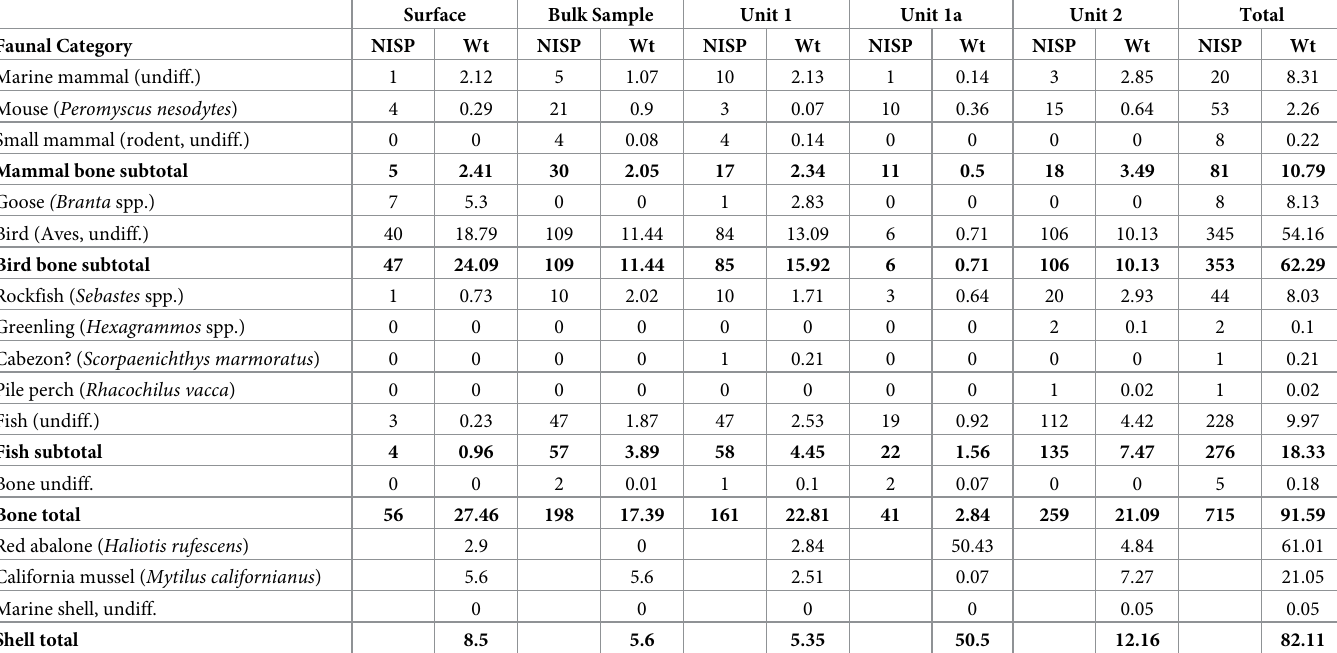
Table 2. Faunal remains from the ~11,700 year old Paleocoastal component at CA-SRI-26 (weights in